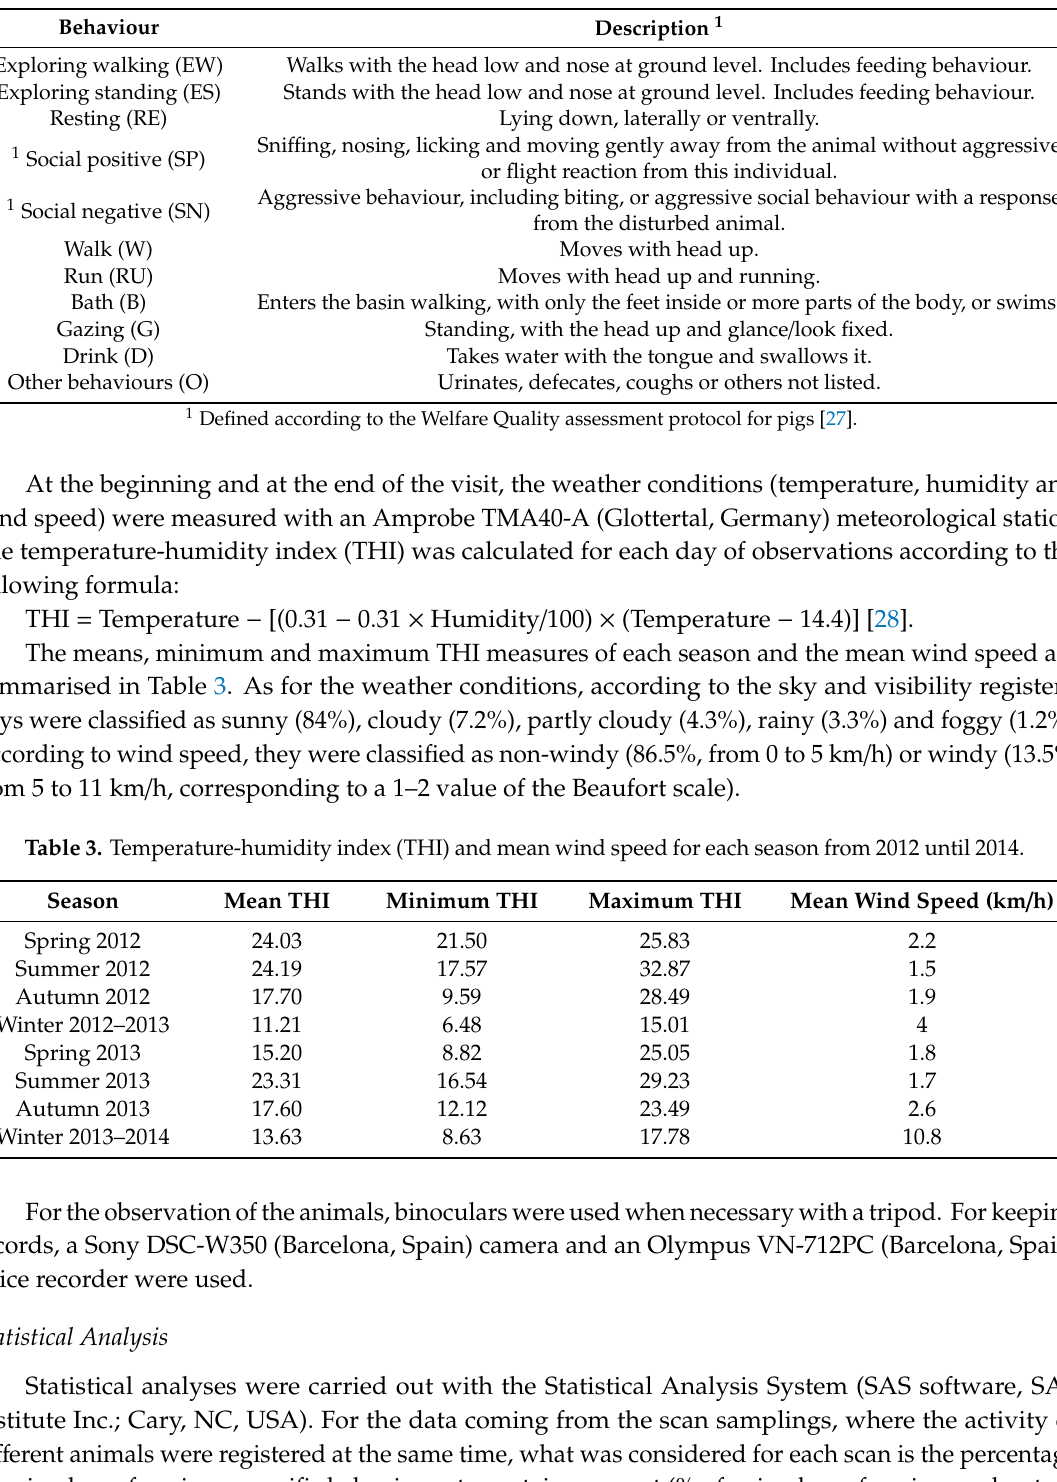
Table 2. Behaviour description for scan and focal sampling.